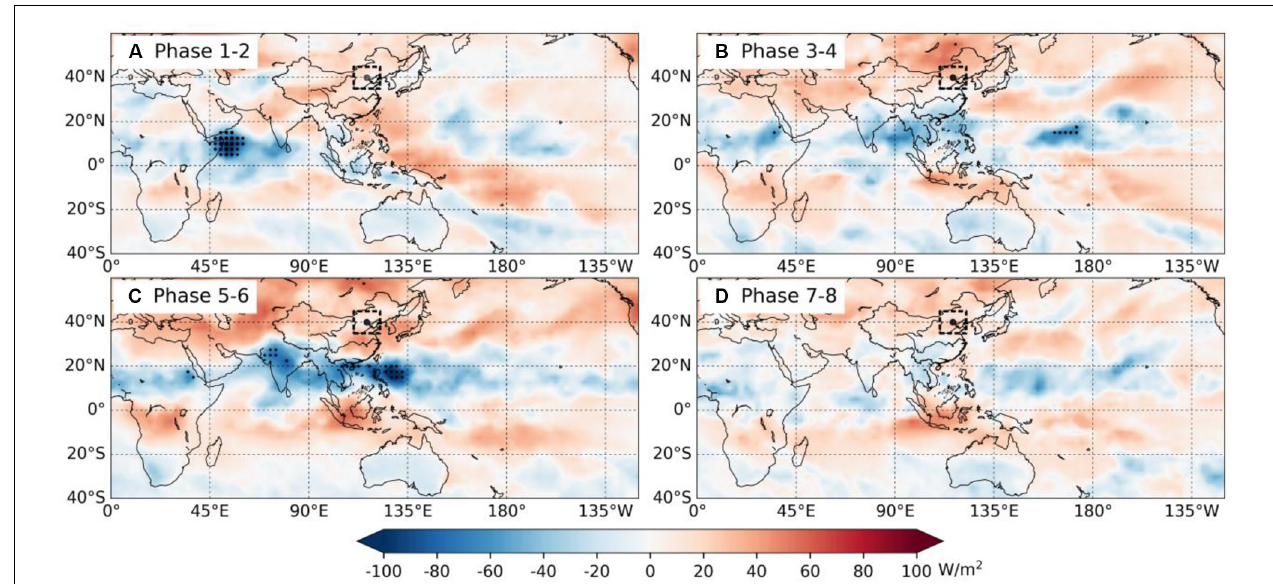
FIGURE 4 | Composites of the OLR anomaly in each phase of MJO in the summer of 2018 (the dotted areas exceed 95% confidence level). Dashed line frame indicates North China area, same as below. Unit: W · m − 2 . (A) The blue shaded areas are the composition of anomalous distribution of outgoing long wave radiation corresponding to the 1-2 phase of MJO, and the dotted areas passed the 95% confidence level. (B–D) The same, but corresponding to the 3-4, 5-6, 7-8 phases of